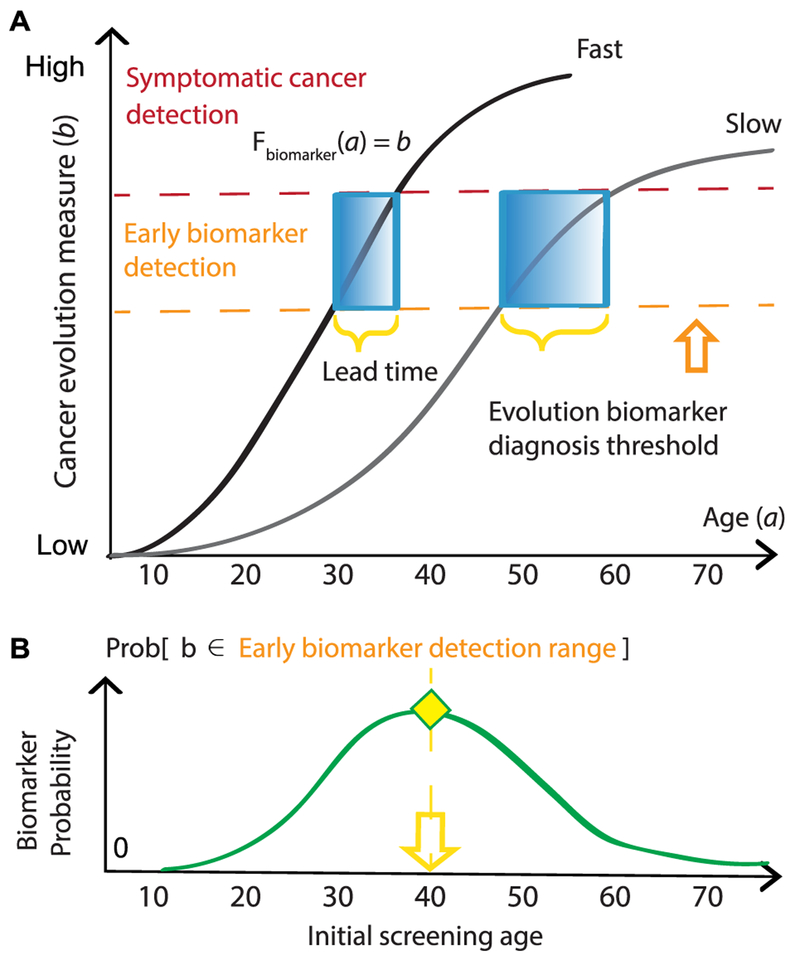
(A) Evolutionary trajectories of slow versus fast carcinogenesis correspond to longer versus shorter lead times for potential clinical intervention, respectively. (B) Screening programme design aims to maximise positive biomarker yield in an average at-risk population.